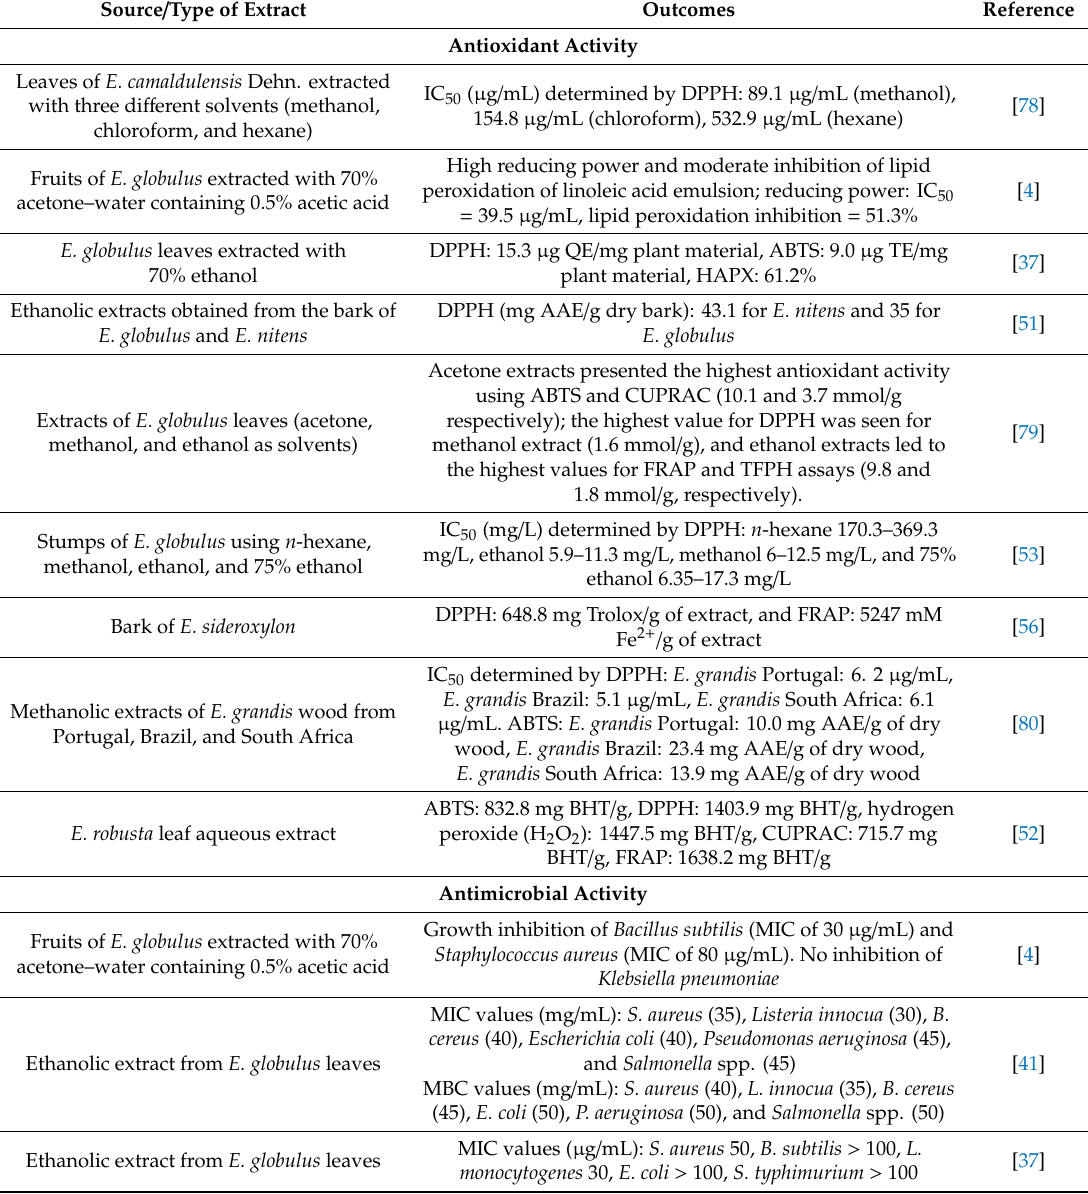
Table 3. Biological activities of the extracts obtained from Eucalyptus